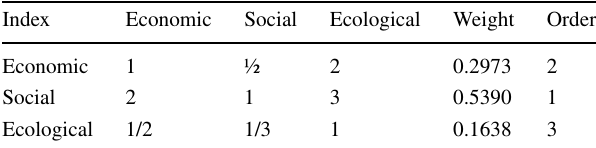
Table 1 Social benefit value of each scenario in